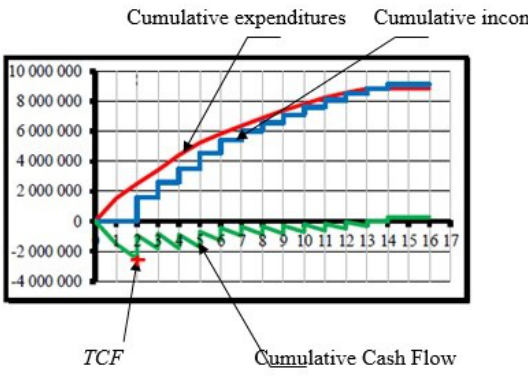
Figure 1: Sample curves of contractor’s cumulative expenditures, client’s cumulative payments and contractor’s cumulative cash flow in the case of regular monthly